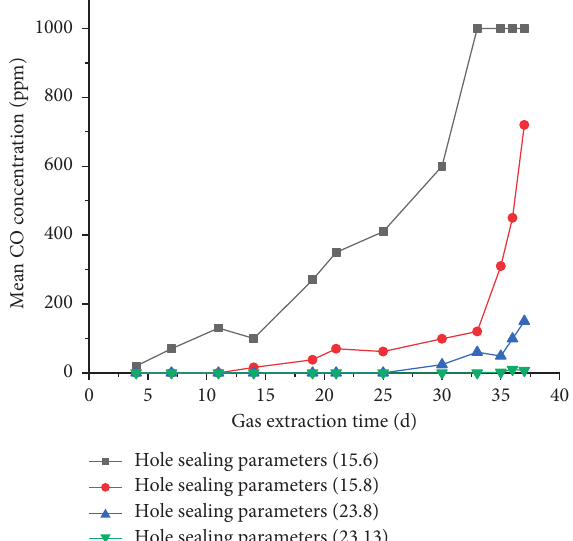
Figure 2: Change curve of average CO concentration in a single borehole under different sealing parameters.